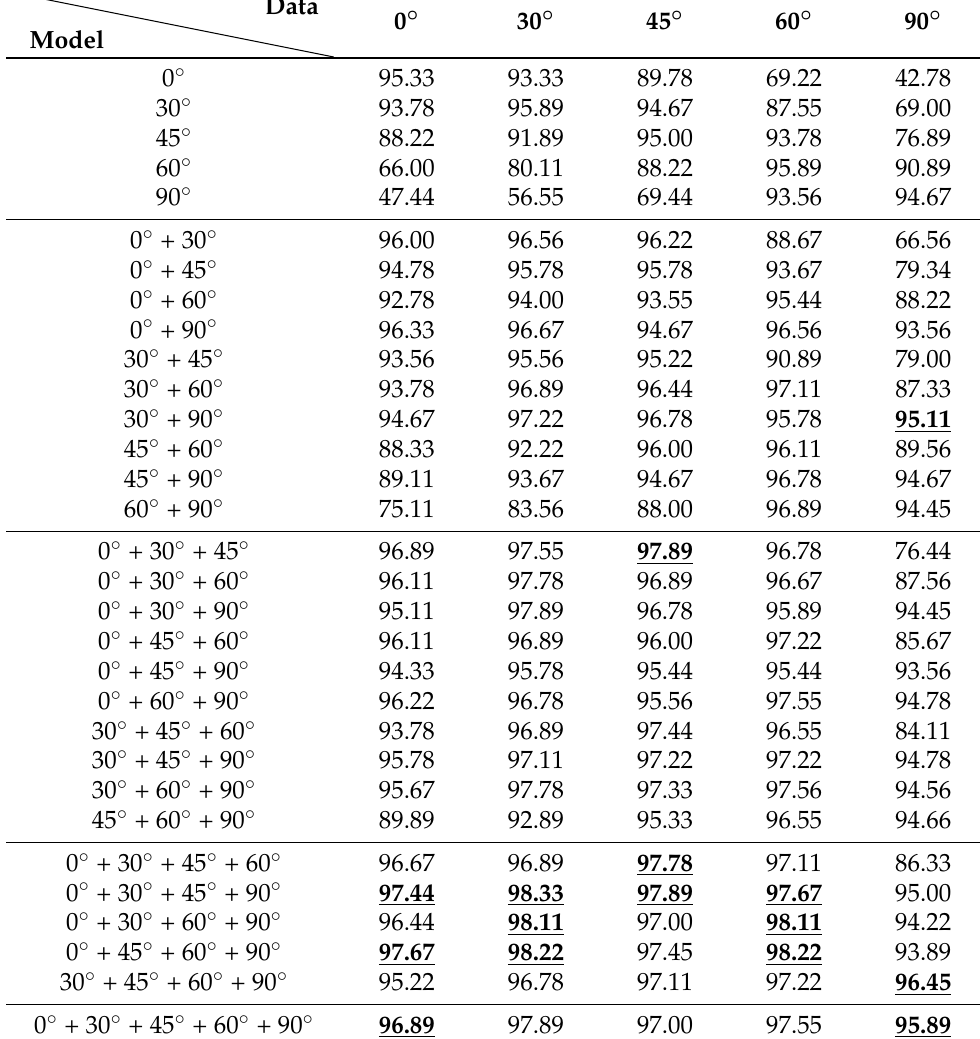
Table 1. Preliminary visual recognition accuracy (%) for validation